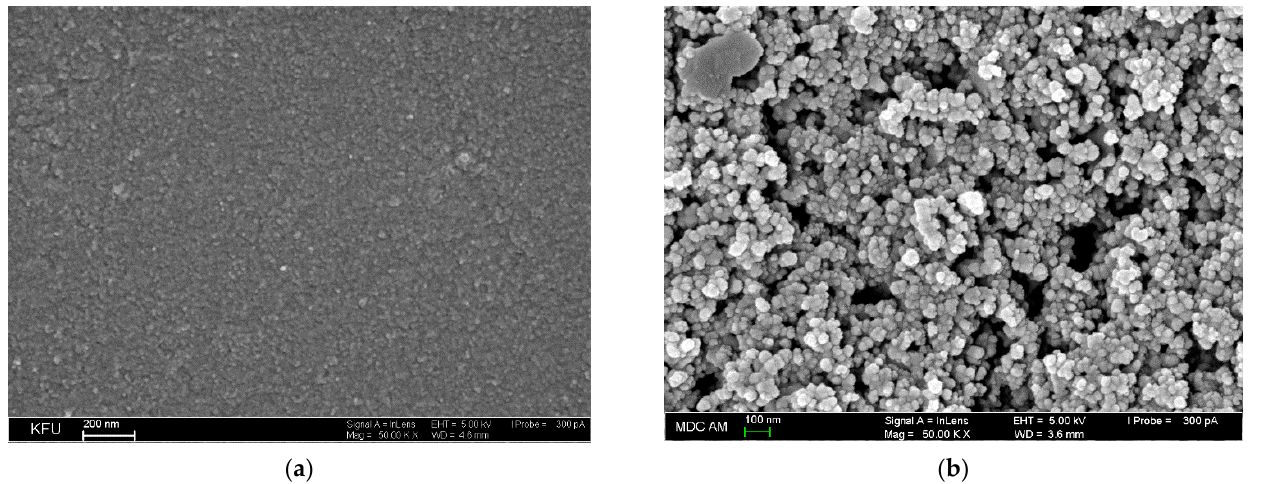
Figure 5. Electrodes surface morphology obtained by scanning electron microscopy: ( a ) bare GCE; ( b ) SeO 2 –CPB/GCE.